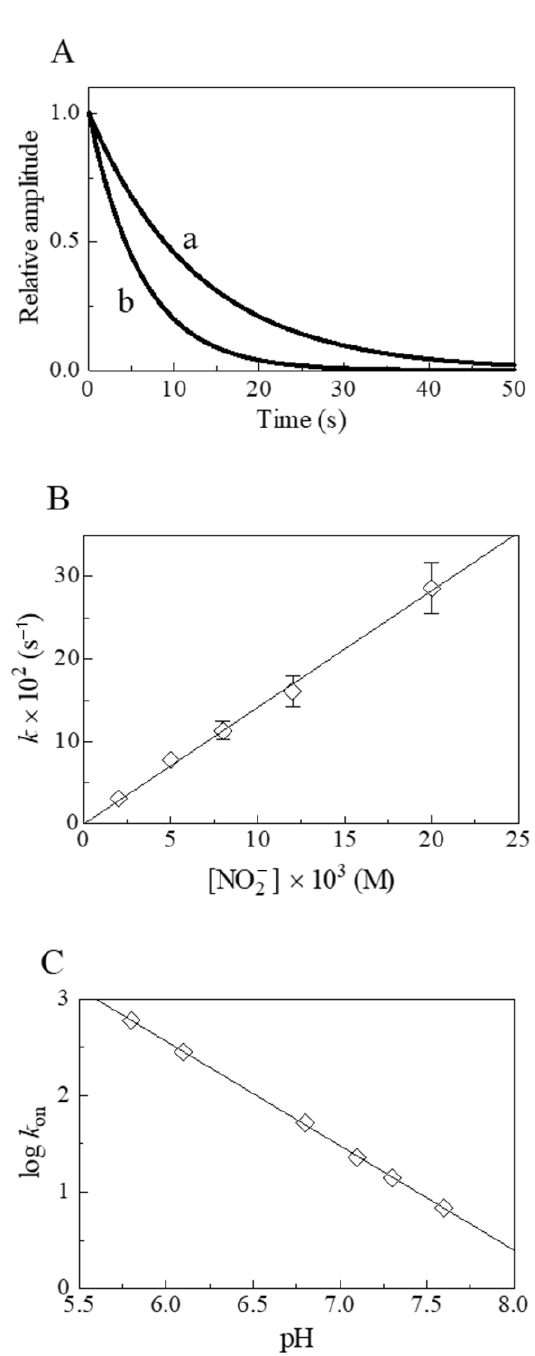
Figure 3. Nitrite reductase activity of Dr -Nb(II) at 20.0 °C. ( A ) Normalized averaged time courses for the NO 2 − -mediated conversion of Dr -Nb(II) to Dr -Nb(II)-NO at pH 7.3 in the presence of 5.0 × 10 −3 M (trace a) and 1.2 × 10 −2 M (trace b) NO 2 − . The time course analysis according to Equation (3) allowed the determination of the following values of k obs : 7.8 × 10 −2 s −1 (trace a) and 1.6 × 10 −1 s −1 (trace b). ( B ) Dependence of k obs on the NO 2 − concentration for Dr -Nb(II) nitrosylation at pH 7.3. The solid line was calculated according to Equation (4) using k on = (1.4 ± 0.2) × 10 1 M −1 s −1 . ( C ) pH-dependence of log k on for the NO 2 − -mediated conversion of Dr -Nb(II). The value of the slope of the continuous lines is − 1.1 ± 0.10. Where not shown, standard deviation is smaller than the symbol.